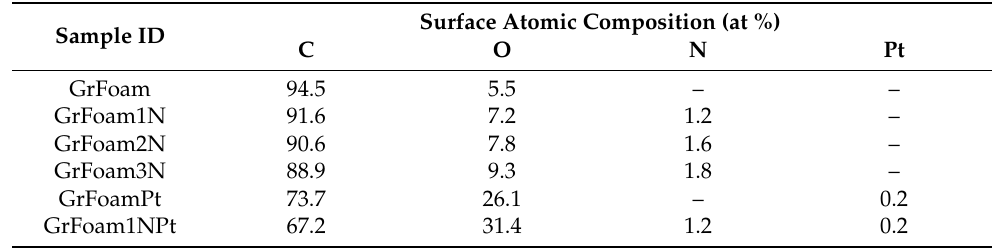
Figure 2. XPS surveys of ( a ) full survey spectrum of GrFoam with C1s inset; ( b ) full survey spectrum of GrFoam1N with C1s and N1s; ( c ) full survey spectrum of GrFoam2N with C1s and N1s; ( d ) full survey spectrum of GrFoam3N with C1s and N1s; ( e ) full survey spectrum of GrFoamPt with C1s and Pt − 4f ; ( f ) full survey spectrum of GrFoam1NPt with C1s inset, and N1s and Pt − 4f . Table 1 lists the surface atomic composition for nitrogen and platinum functionalized graphene foam determined from XPS measurements. Table 1. Surface atomic composition for nitrogen and platinum functionalized graphene foam determined from XPS